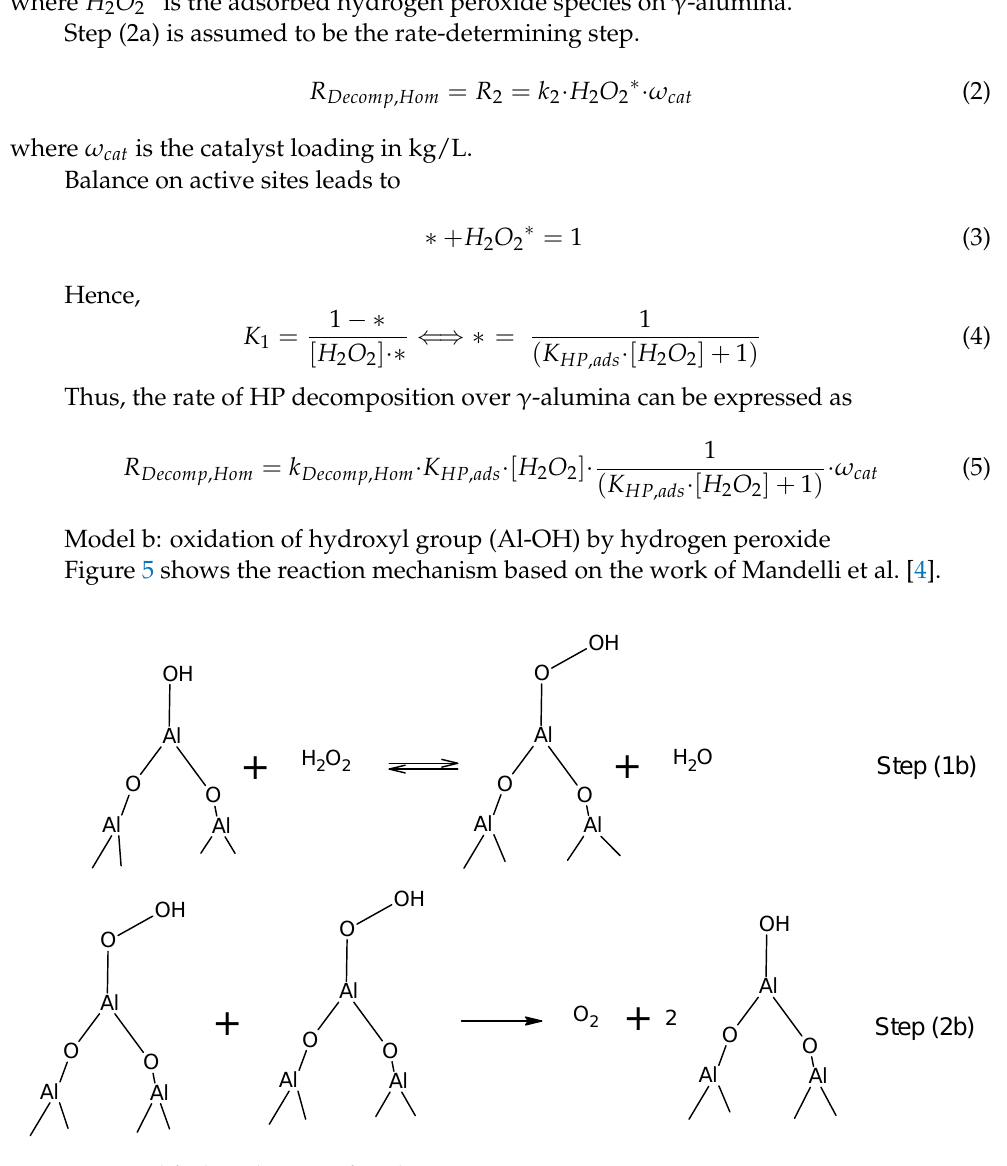
Figure 5. Simplified mechanism of oxidation.